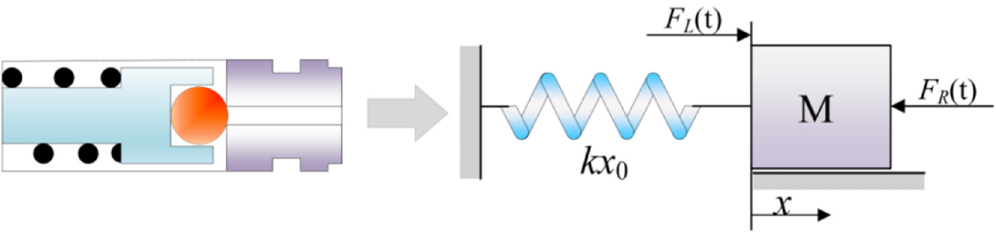
Figure 18. Simplification of the pilot outlet valve. The condition for the pilot outlet valve to be reliably closed is F L ( t ) > F R ( t ) during the opening process of the proportional valve. At the moment when the main inlet spool is opened, F L 0 and F R 0 can be expressed as: The pre-compression of the pilot spring should be greater than 5 mm, because the maximum valve opening of the main inlet valve is 5 mm. Therefore, the pre-compression is 6 mm to ensure reliability in Equation (4), and the calculation result is k > 3 N/mm. The dynamic change process of F R and F L during the opening process is analyzed through the simulation model. F L should always be greater than F R to ensure the stability of the system during the opening process. In other words, the F L curve should always stay above the F R curve. The force change curve is shown in Figure 19 under step signal when the stiffness of the pilot spring changes from 3 N/mm to 7 N/mm.